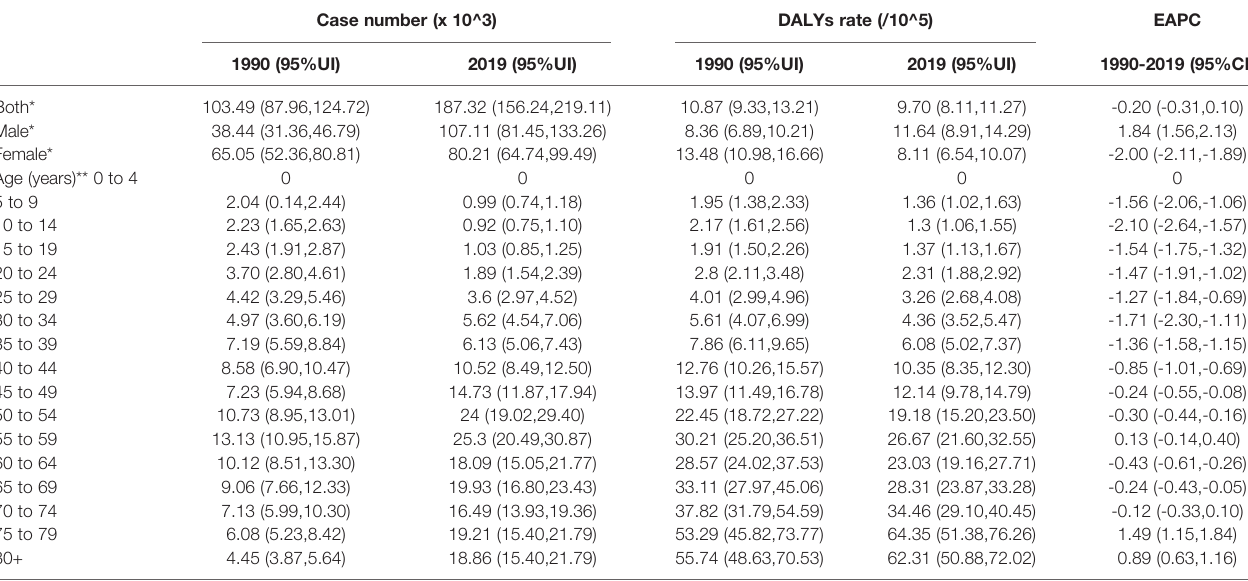
TABLE 3 | The number and DALYs rates of thyroid cancer in China by sex and age